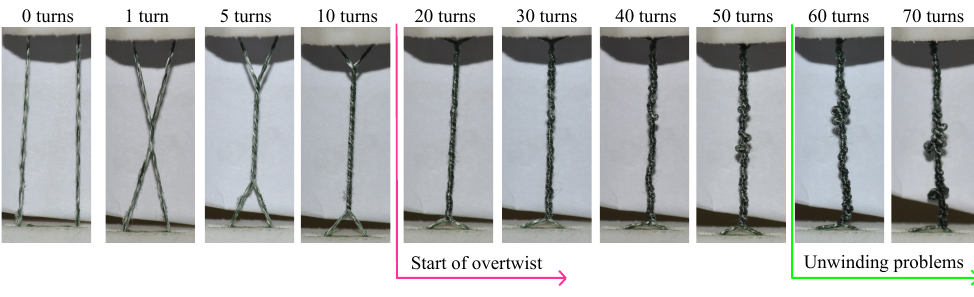
Figure 8. Twisted string system with an overtwisting phase.